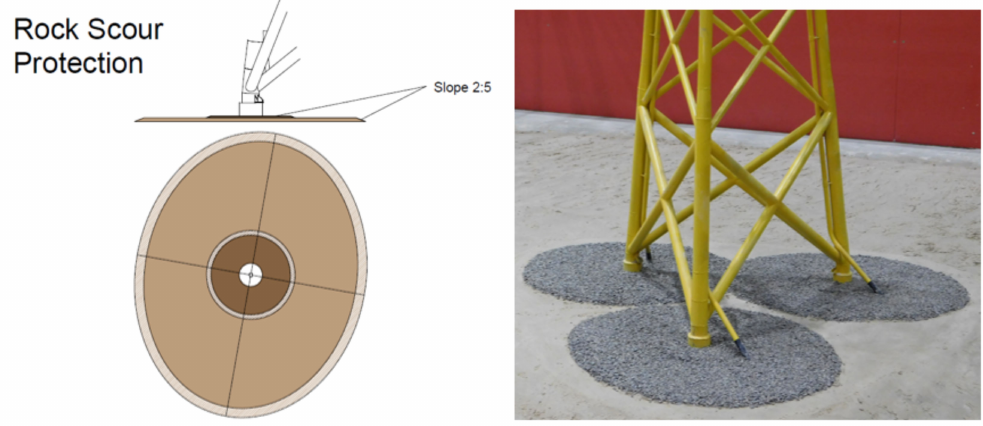
Figure 2. Footprint of the rock scour protection. IHCantabria. Test scale 1:30.